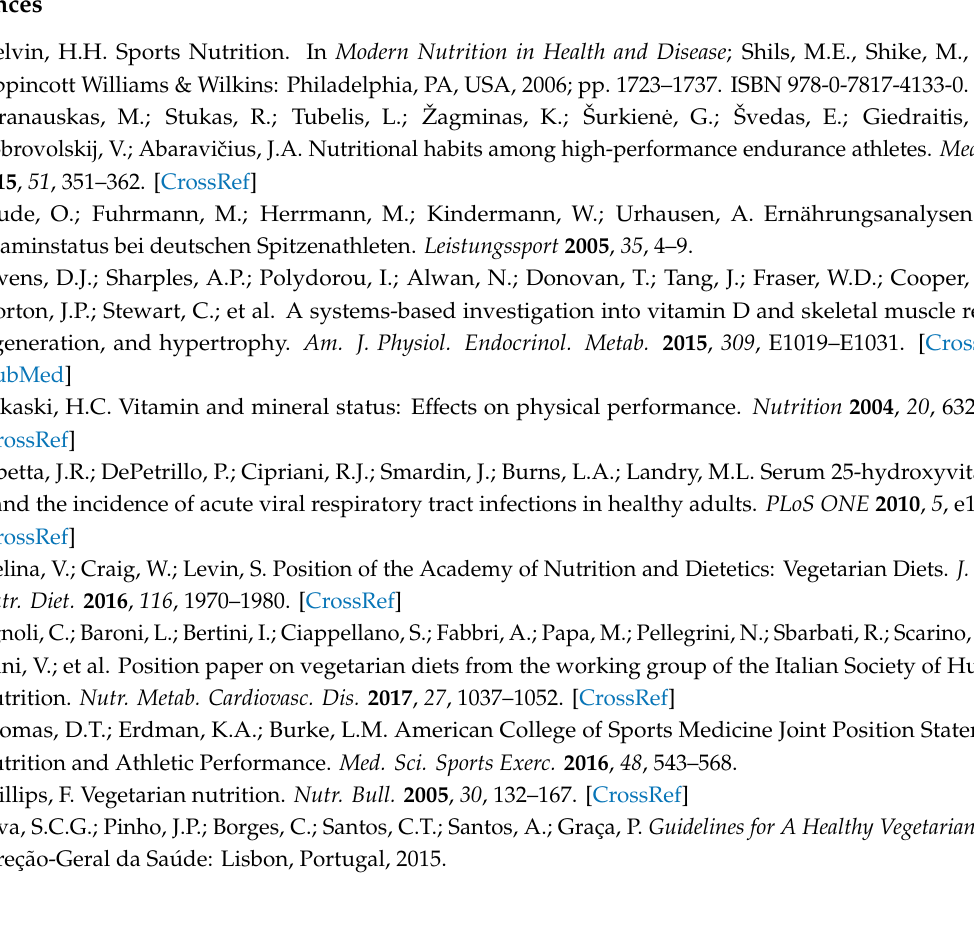
Table S1: Biomarkers of iron status and hematological parameters according to gender, Table S2: Biomarkers of vitamin D status according to gender, Table S3: Biomarkers of iron status and hematological parameters according to supplement